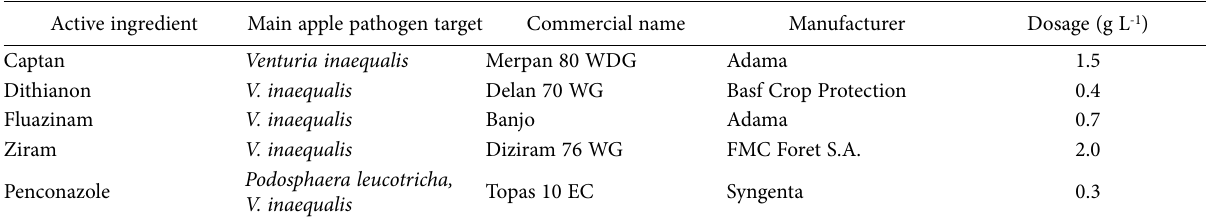
Table 1. Fungicides tested against Diplodia seriata . Active